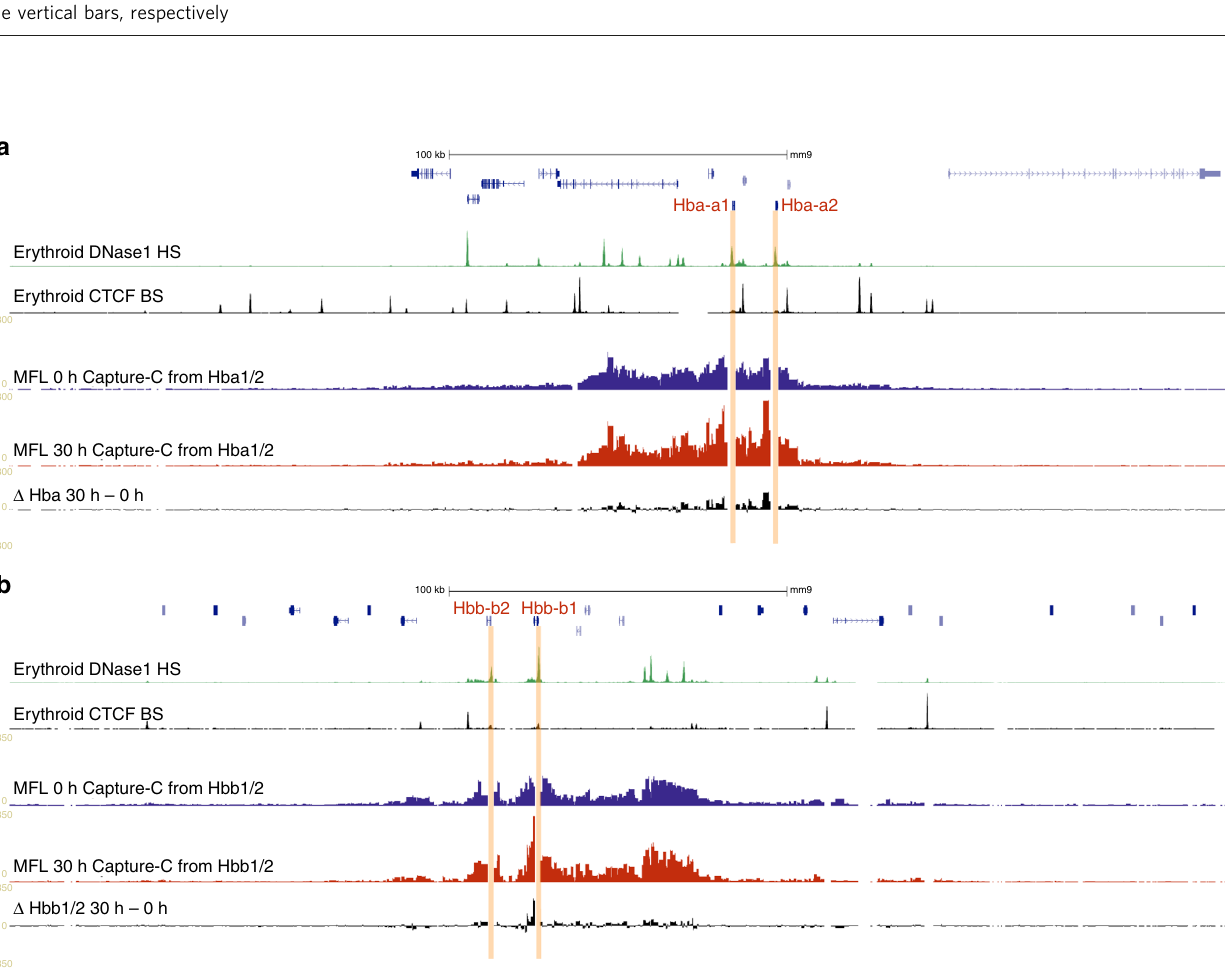
Fig. 2 Self-interacting domains are already formed at globin loci in MFL 0 h erythroblasts. a NG Capture-C tracks using Hba1/2 as viewpoints in MFL erythroblasts at 0 h (blue) and 30 h (red) with a differential track (black) showing minimal changes between the two timepoints. b NG Capture-C tracks using Hbb1/2 as viewpoints in MFL erythroblasts at 0 h and 30 h with a differential track showing minimal changes between the two timepoints